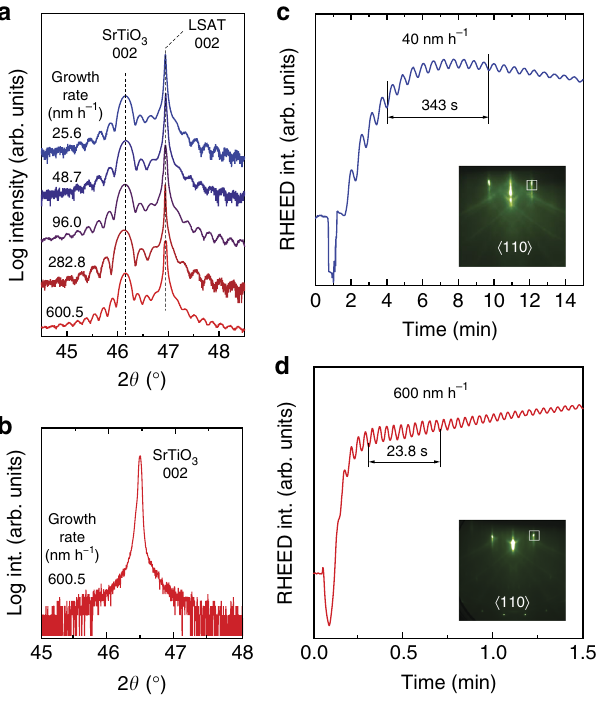
Fig. 5 Virtual perovskite oxide substrate on Si. a Wide range 2 θ – ω X-ray scan of a ~126-nm-thick SrTiO 3 fi lm grown on 3in Si wafer at a growth rate of 240 nm h − 1 . b Rocking curve ( ω -scan) of the 002 SrTiO 3 peak with a full width at half maximum (FWHM) of 0.28°. c Reciprocal space map of the 103 SrTiO 3 fi lm peak in reciprocal lattice units of stoichiometric SrTiO 3 . d Atomic force microscopy image of the SrTiO 3 on Si with “ epi-ready ” step terrace morphology and a surface roughness (RMS) of ~1nm. A line pro fi le of the fi lm is shown above. Scale bar on AFM image is 200 nm. e Photograph of the perovskite oxide virtual substrate, a SrTiO 3 metamorphic buffer layer on a 3-in Si wafer. The SrTiO 3 fi lm is transparent, the yellow coloration is from interference due to its fi nite thickness ( λ /4). f Wafer scale map of SrTiO 3 fi lm thickness on Si obtained from spectroscopic ellipsometry with a smaller than 1% fi lm thickness variation across the wafer